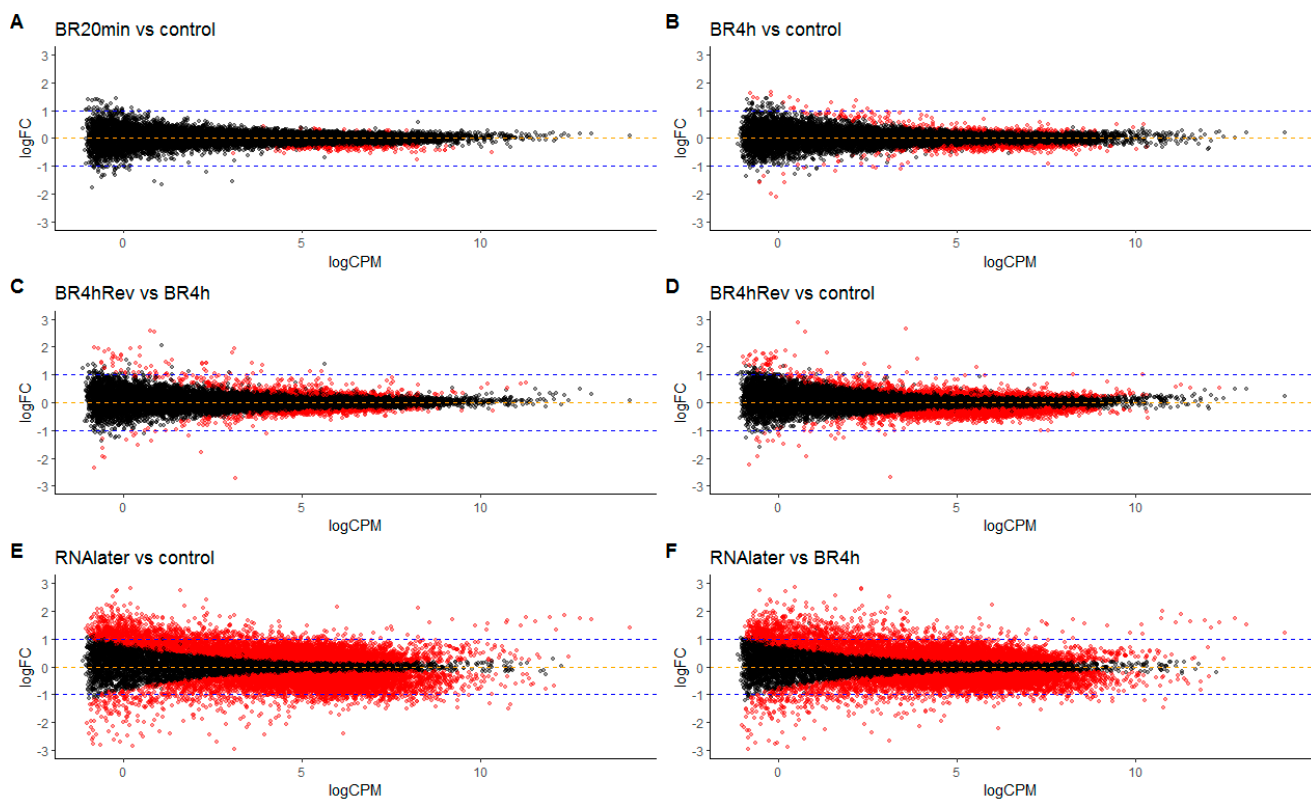
Figure 6. Changes in gene expression in the cells with neodymium ( A , B ), RNAlater ( E , F ), and after restoration of the cells to growth medium ( C , D ). Each point represents a gene with its average level of expression (logCPM, where CPM is “Counts Per Million reads”) and the degree of expression change between given pairs of samples (logFC, where FC is “Fold Change”). The specific logFC rate indicates changes of gene expression in the first sample in pairs compared to the second one. Red points correspond to genes with statistically significant changes of expression.